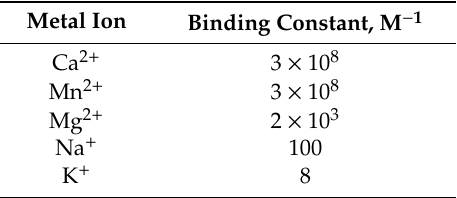
Table 2. Apparent binding constants of biologically significant metal cations for bovine α -LA at 20 ◦ C